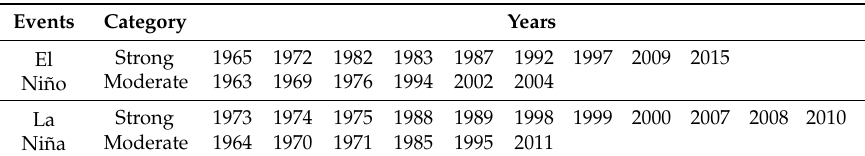
Table 2. The selected El Niño and La Niña years and their categories.